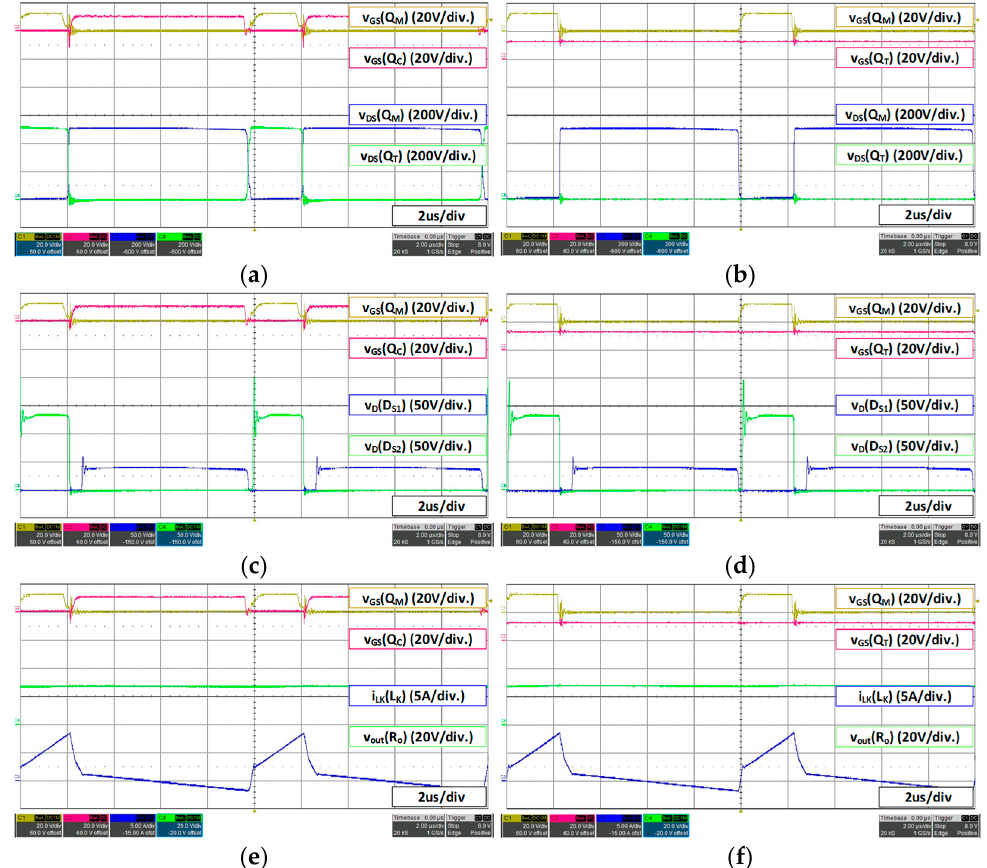
Figure 12. 36 V battery (27 V 15 A) load waveform: ( a ) conventional converter MOSFET voltage stress; ( b ) proposed converter MOSFET voltage stress; ( c ) conventional converter secondary rectifier voltage stress; ( d ) proposed converter secondary rectifier voltage stress; ( e ) conventional converter V out ; ( f ) proposed converter V out .